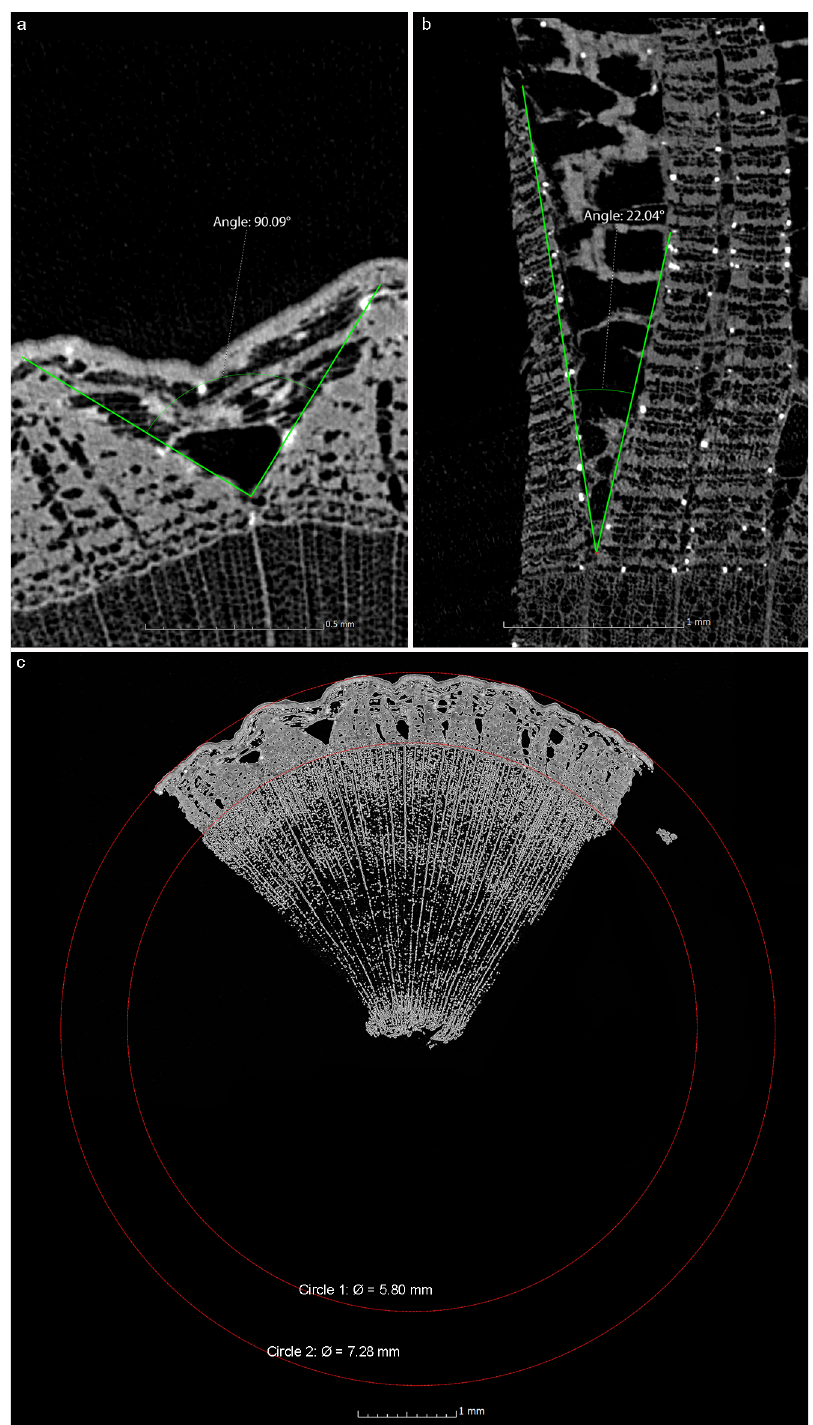
Figure 6. µCT cross sections of the largest angle of a phloem ray in the bark of lime branch ( a ) sample 2 and ( b ) sample 1. ( c ) µCT cross section showing the diameter of the organ from which the bark of a lime shoot (sample 2) was taken, calculated by extrapolating the complete circumference and tree-rings from the existing